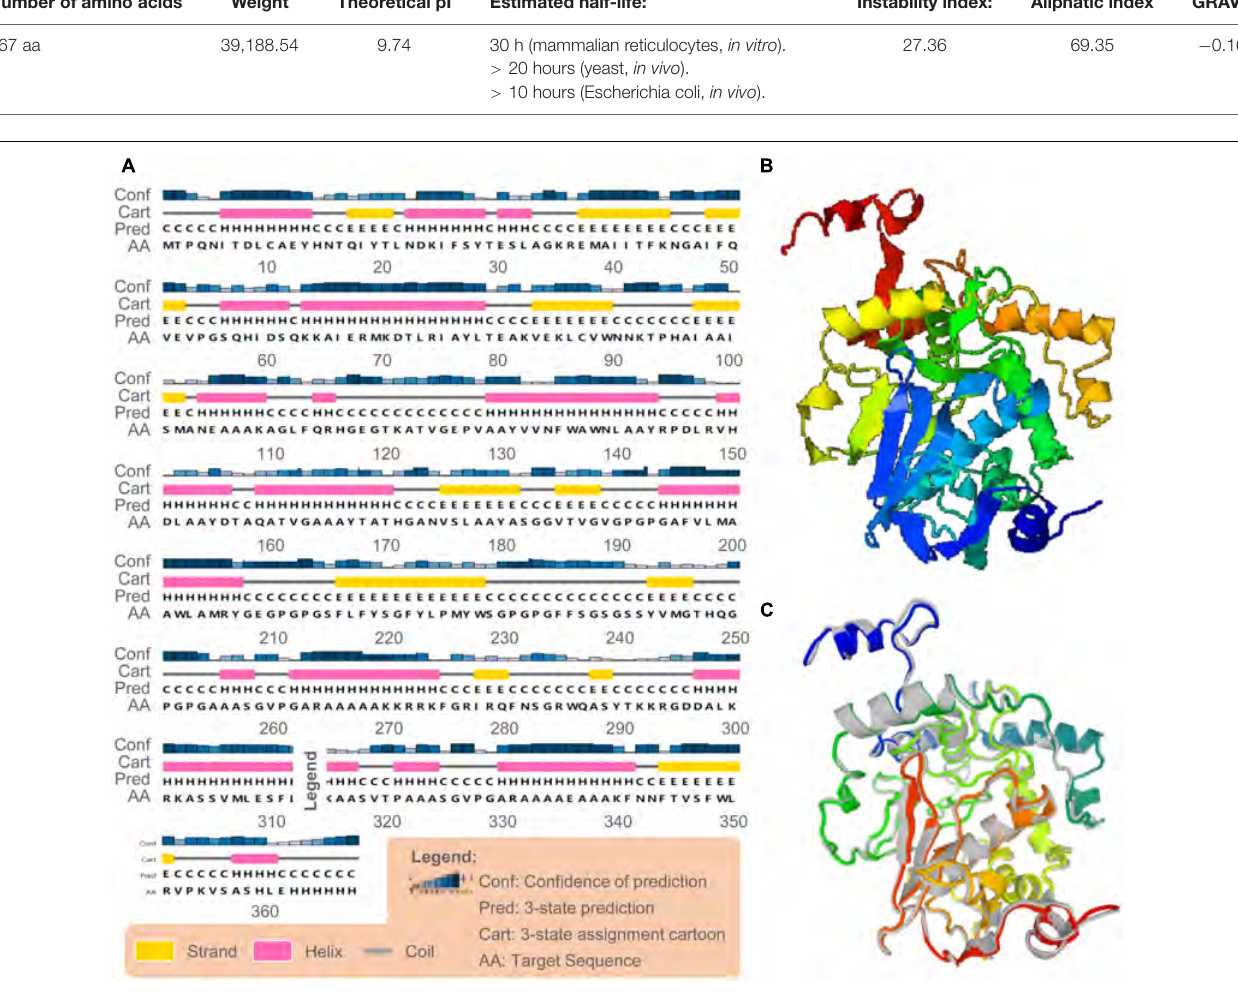
C543P candidate contains 43.6% α -helix, 15.8% β -strand,